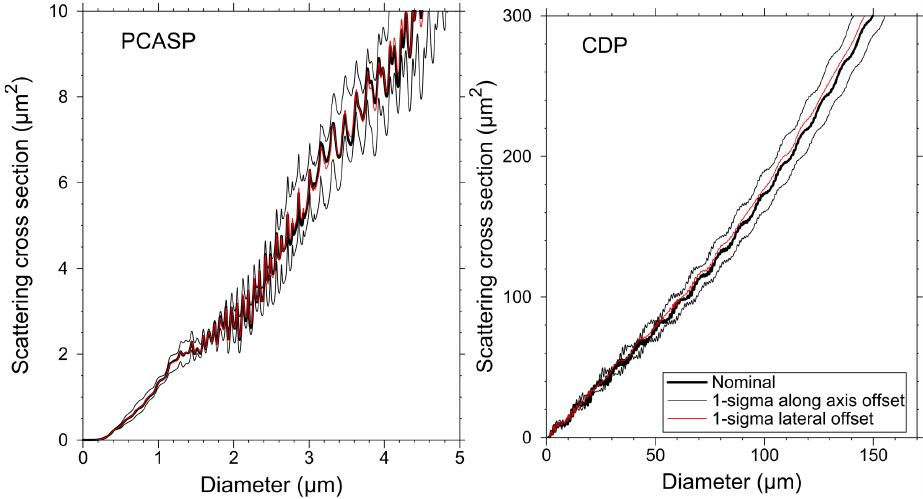
Fig. 9. Mie-Lorenz curves for the PCASP and CPD showing the impact of misalignment of the optics for desert dust. The thick black line shows the scattering cross section measured by the instruments using the nominal manufacturer’s specification. The thin red and black lines show the impact of moving the sample/laser intersect point or sample volume along the laser axis or laterally in a direction perpendicular to the laser axis. The 1-sigma offsets are estimates of the variation from nominal for a typical instrument and are based observed offsets of FAAM’s PCASP after realignments, measurements of a number of CDPs by the manufacturer (Baumgardner, 2012) and measurements by Lance et al.